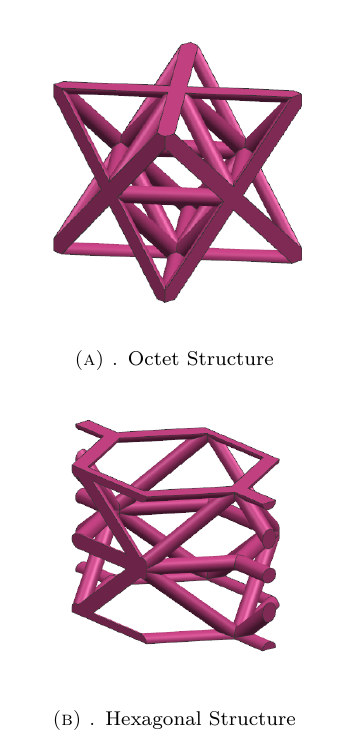
Figure 1. Lattice Structures